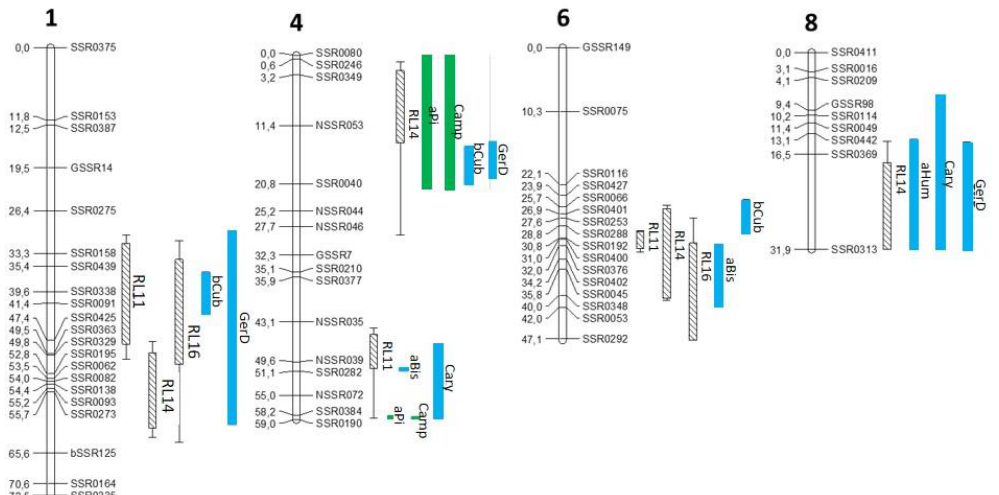
Figure 2. Co-localization between rQTL and mQTL of terpenes presenting significant negative corre- lation with ALB disease score. rQTL are named RL for resistance loci with the year of phenotyping. The confidence interval is bordered by two small vertical lines for the 1.5 LOD support interval (SI). A hatched area represents a 1 LOD SI. Metabolite-QTL is named with an abbreviation of each terpene: aPi = α -pinene, Camp = camphene, aBis = α -bisabolene, aHum = α -humulene, bCub = β -cubebene, Cary = caryophyllene, GerD = germacrene D. Monoterpene and sesquiterpene mQTL are represented with green and blue bars, respectively, with a 1 LOD SI. Table 1. Characteristics of terpene mQTL co-localizing with rQTL and significantly correlated with disease score on carrot leaves after A. dauci attack. SI = support interval; Chr = chromosome; RL= resistance loci; R 2 = e xplained phenotypic variation; cM = centimorgan. aPi = α -pinene, Camp = cam- phene, aBis = α -bisabole ne, aHum = α - humulene, bCub = β -cubebene, Cary = caryophyllene, GerD = germacrene D; t and b = top and bottom of Chr respectively.